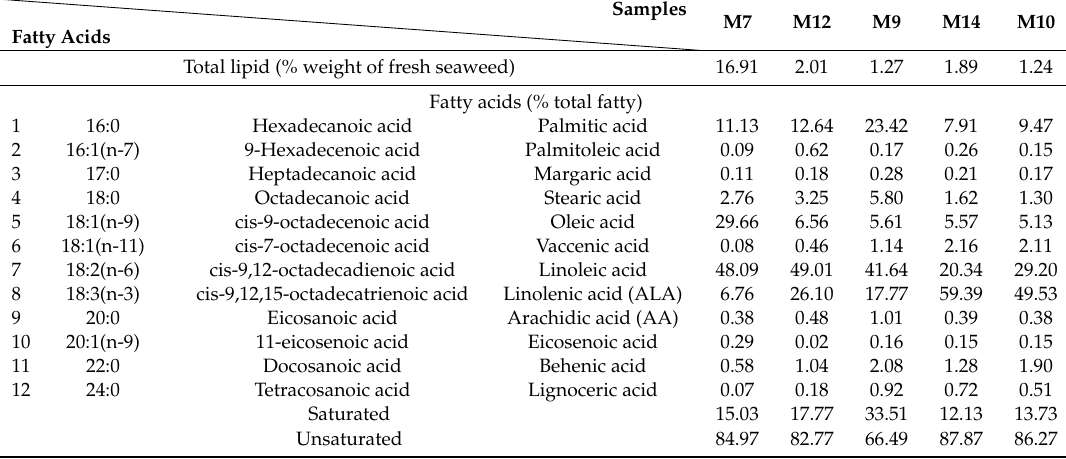
Table 1. List of compositions fatty acids from five Fabaceae seed